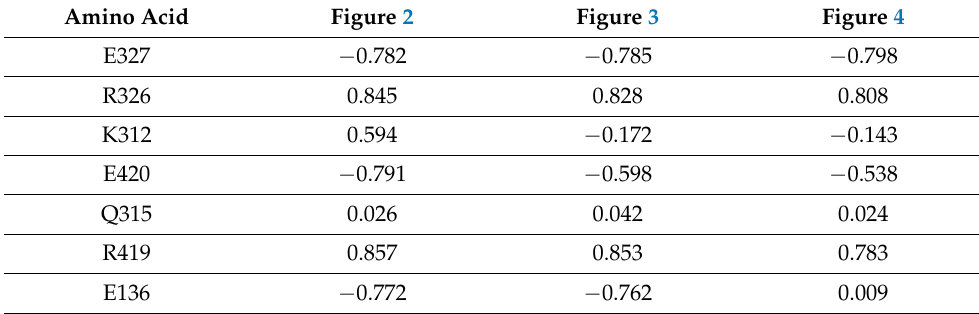
Table 3. Charges on side chains of important amino